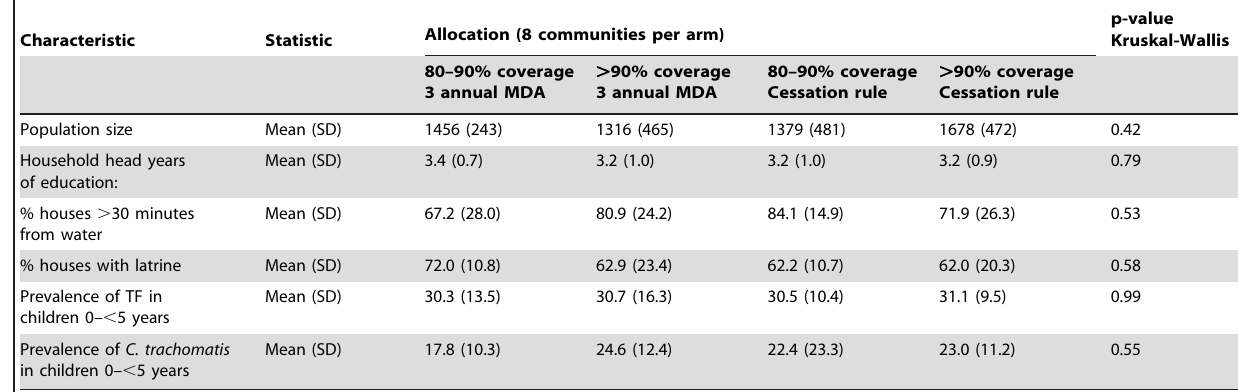
Table 1. Baseline characteristics by randomization group.